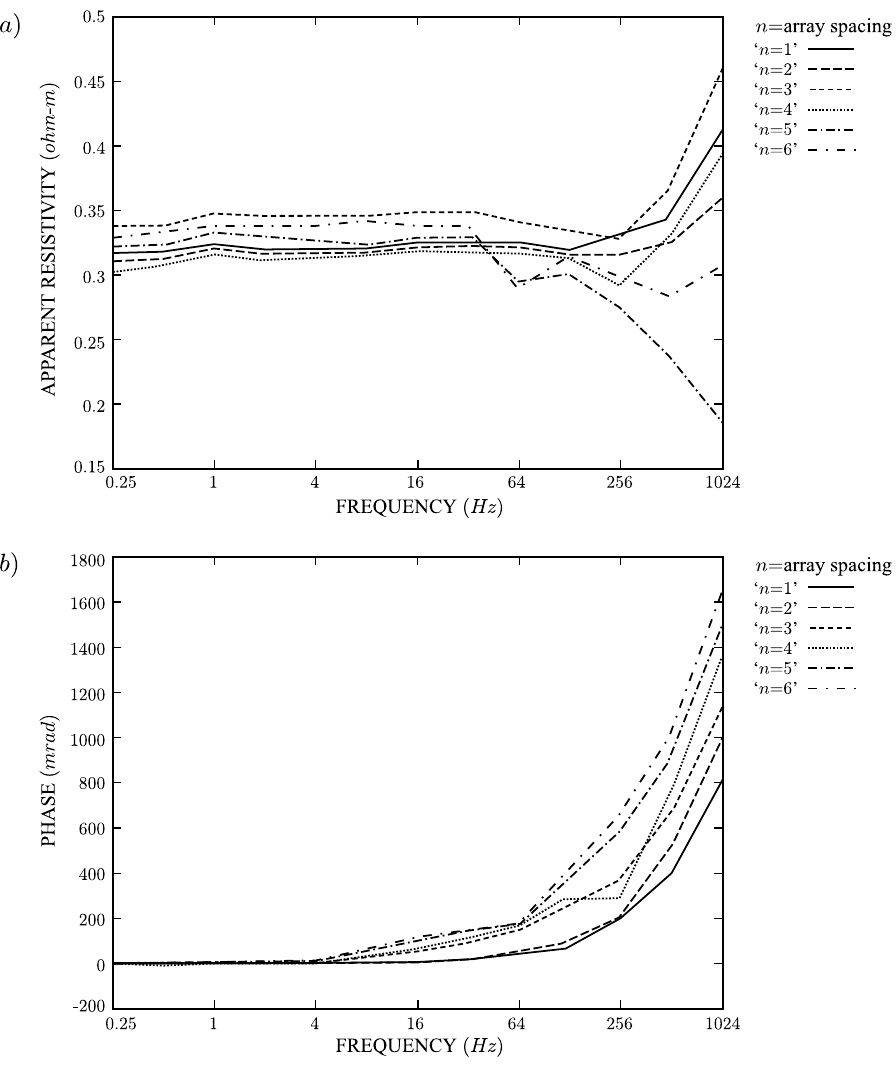
Fig. 7 – Behavior of (a) the amplitude and (b) the phase of the apparent resistivity at the sea bottom, for the six array spacing of investigation, and for the bar electrode (0.10